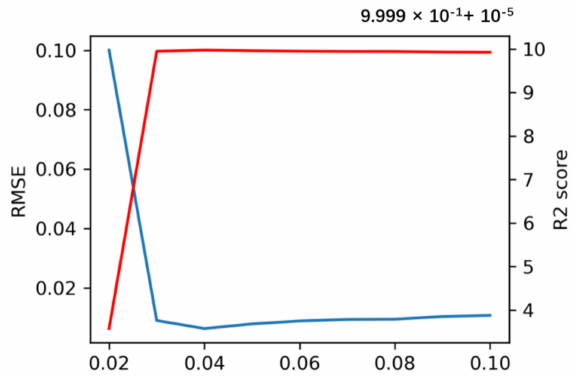
Figure 3. learning_rate adjustment diagram.